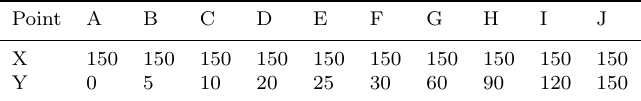
Table 2. Coordinates of the considered point